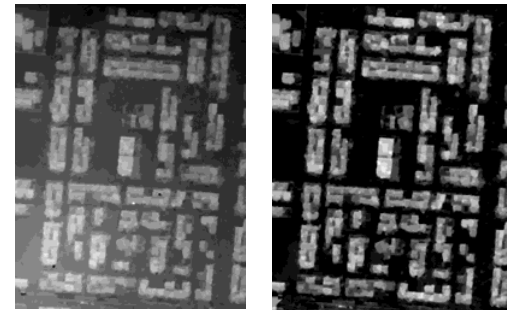
Figure 4: DSM (left) and nDSM (right) of the area shown in Fig.